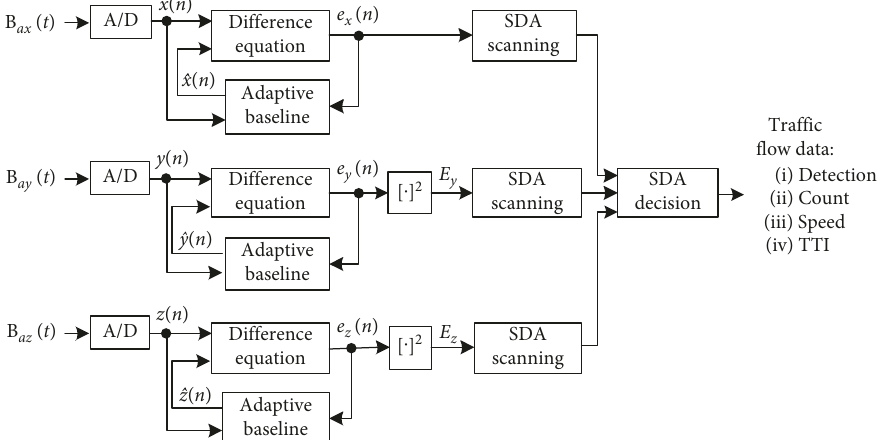
Figure 7: Block diagram of the SDA algorithm for magnetic WSNs showing data inputs, processes, and the